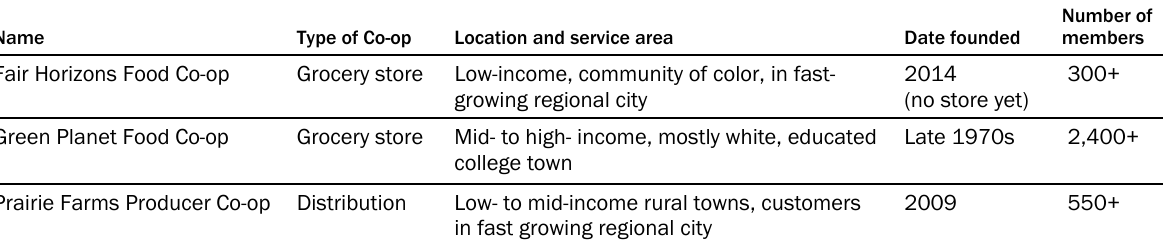
Table 2. Three Cooperative Cases